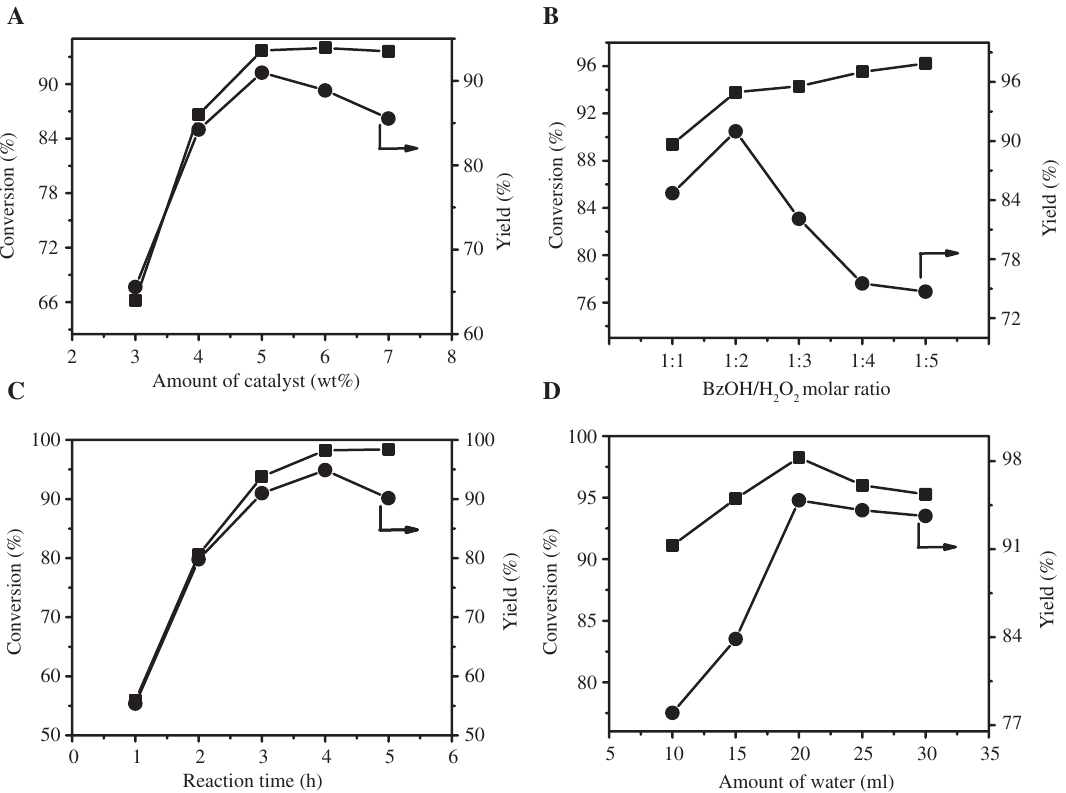
Figure 2: Effects of (A) amount of catalysts, (B) benzyl alcohol to hydrogen peroxide molar ratio, (C) reaction time, and (D) amount of water on conversion (●) and benzaldehyde yield (■), during oxidation of BzOH with H